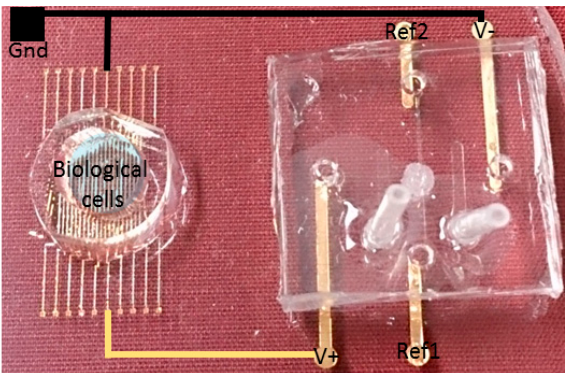
Figure 16. The first PDMS (polydimethylsiloxane) system for hybrid experiments. In the left part, “in vitro” neurons cultured on a gold microelectrode array (20 electrodes). In the right part, the microfluidic neuron described previously.